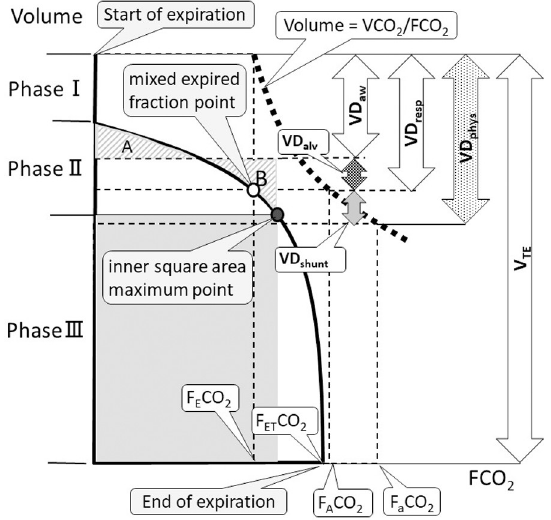
Fig 1. Components of dead space and volumetric capnography. The expired tidal volume on the Y axis is plotted against the partial pressure of expired CO 2 on the X axis in order to express the curve of ‘Volume = VCO 2 /FCO 2 ’. Phase I represents CO 2 -free and pure dead space, phase II represents the transition between airway and alveolar gas, and phase III represents alveolar gas. Phase II ends at the inner square area maximum point. The VD aw is